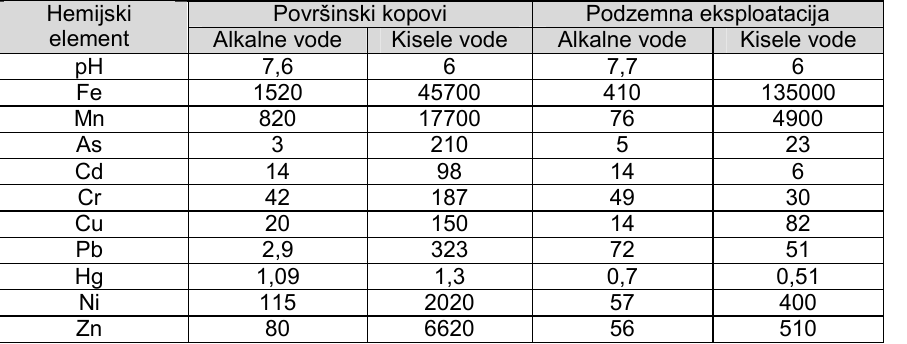
Prose č an sadržaj štetnih i opasnih elemenata ( μ g/l) u rudni č kim vodama iz ležišta uglja Average content of harmful and dangerous elements ( μ g / l) in mine water from coal mines Površinski